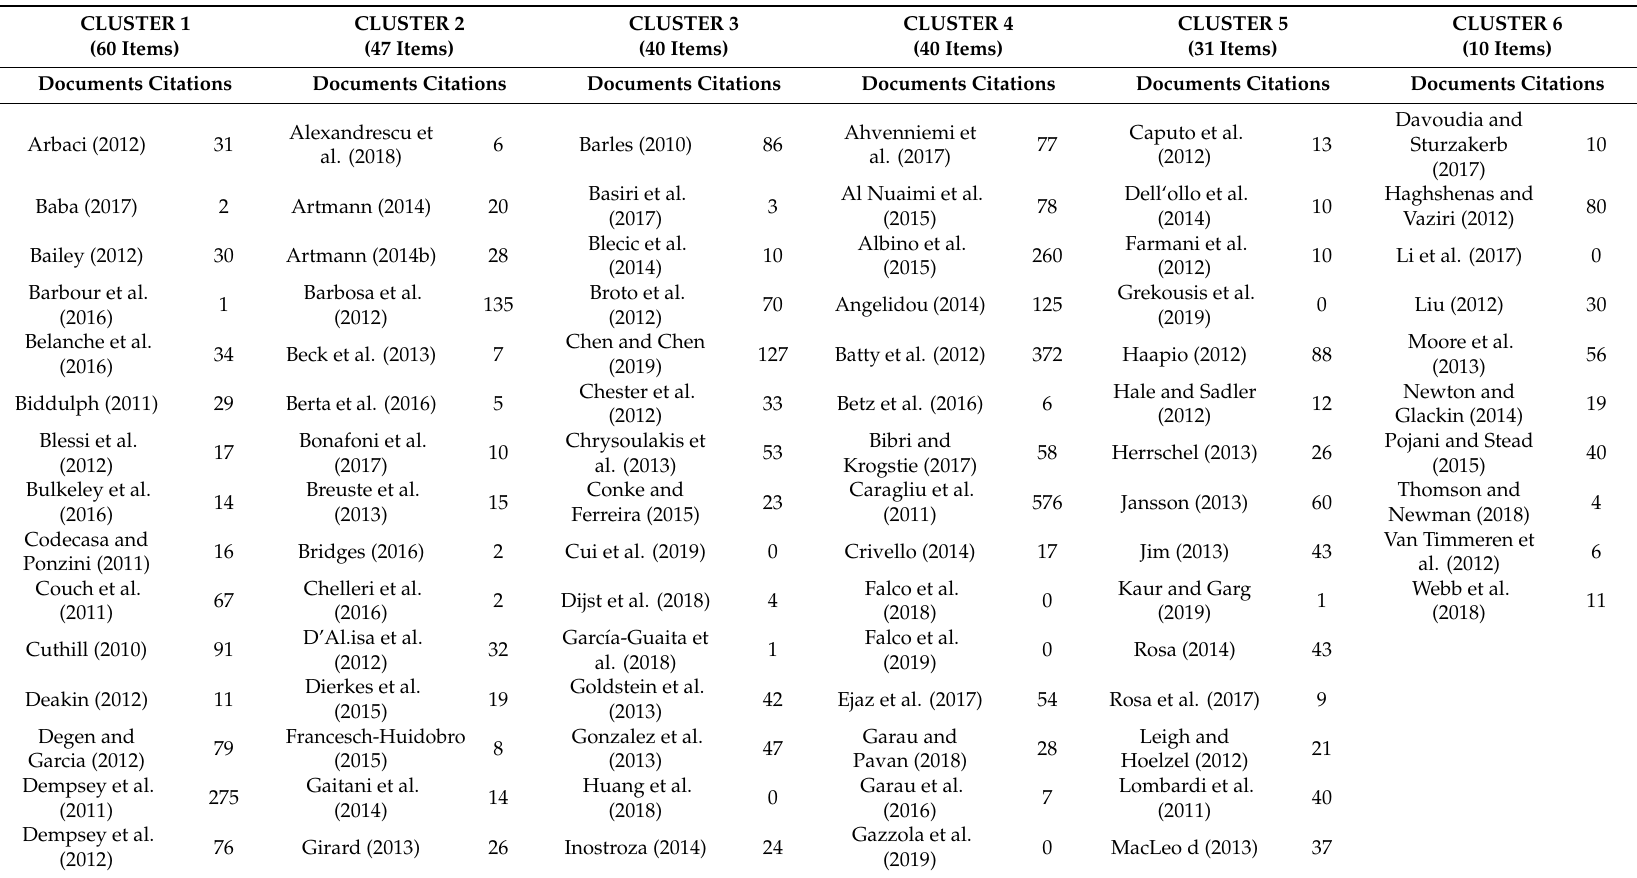
Table A1. Number of citations of documents per cluster based on the bibliographic coupling